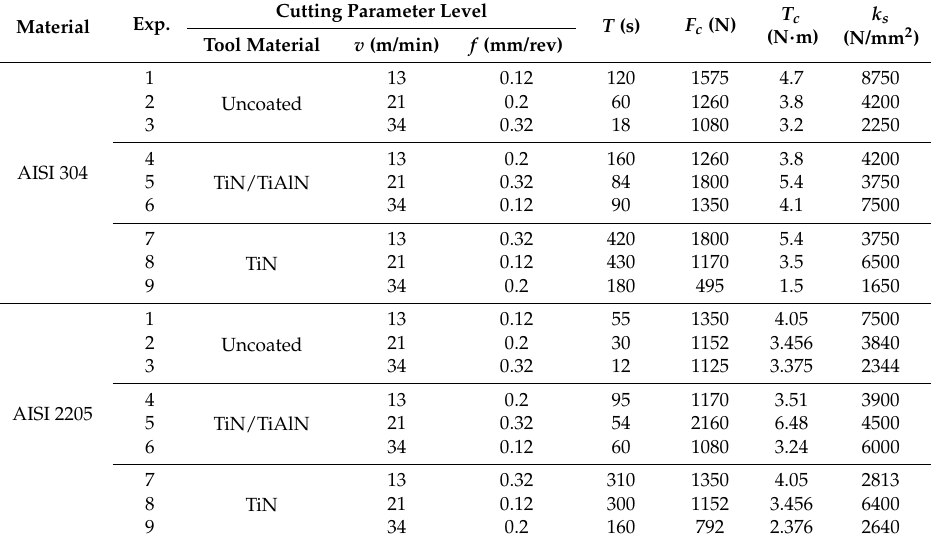
Table 5. Experimental design using the L9 orthogonal array and experimental results.